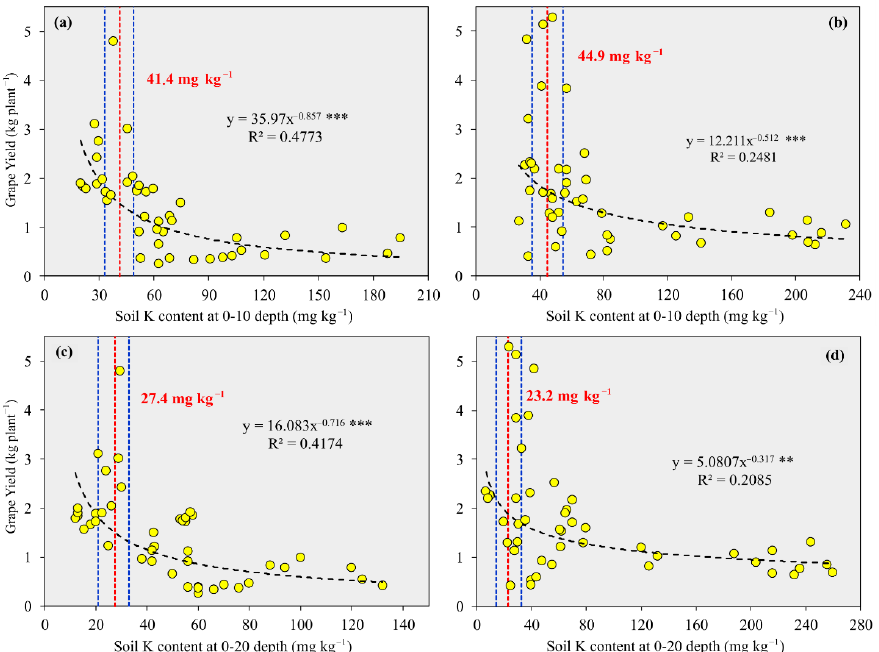
Figure 6. Soil K critical content at 0–10 and 0–20 cm depth in ‘Chardonnay’ ( a , c ) and ‘Pinot Noir’ ( b , d ) cultivated in sandy soil and fertilized with K. Vertical blue dotted lines represent the range of probability of occurrence (95% highest density interval) of the CL of K. Vertical red dotted lines are the CL value of soil K content. The black dotted line is the behavior of the equation (grape yield variable). “**” Significant at 1% ( p < 0.01). “***” Significant at 0.1% ( p < 0.001).